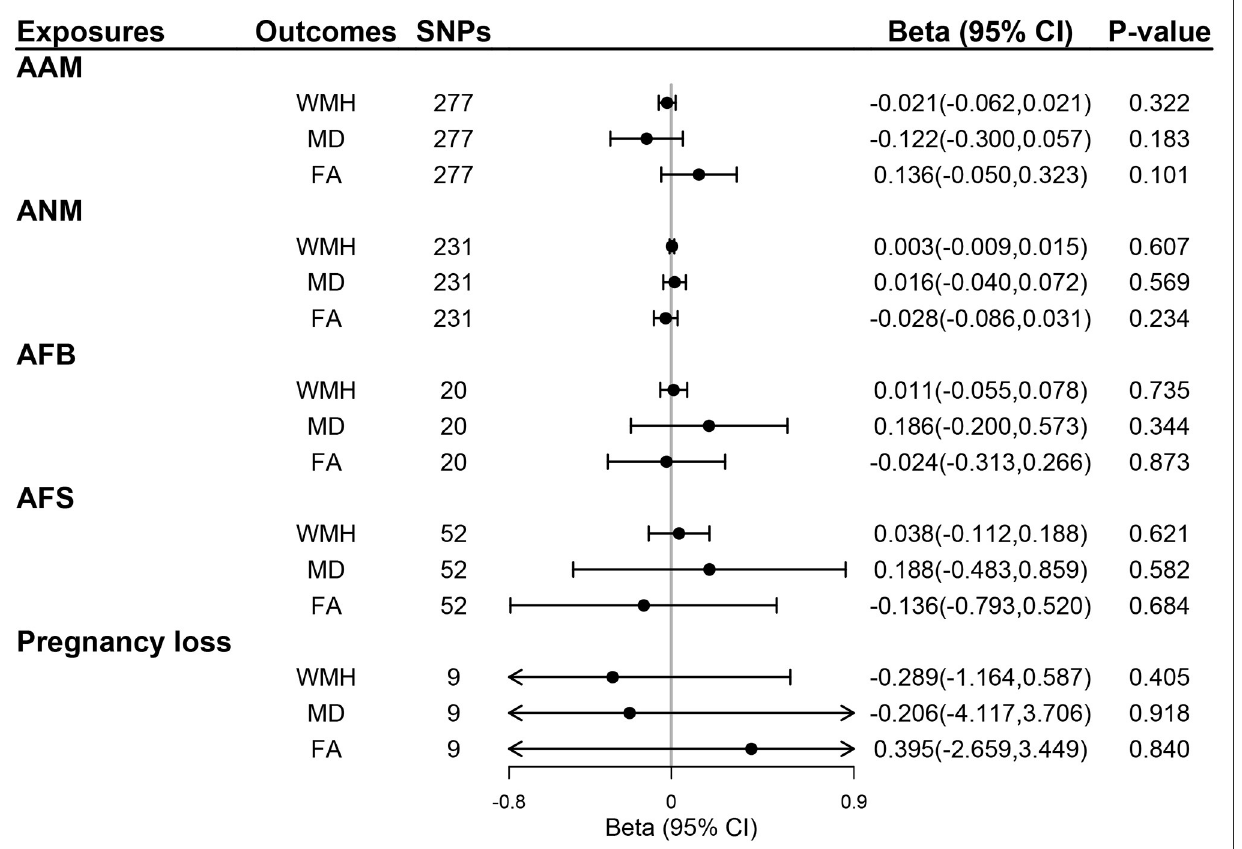
FIGURE3 The effect of genetically determined women’s reproductive traits on MRI markers of CSVD using UVMR. AAM, age at menarche; AFB, age at first birth; AFS, age at first sexual intercourse; ANM, age at natural menopause; FA, fractional anisotropy; MD, mean diffusivity; WMH, whiter matter